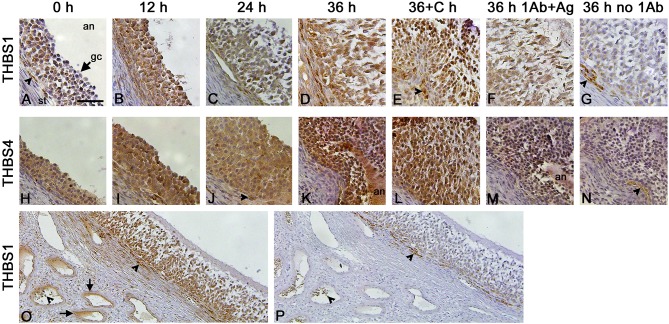
THBS1 and THBS4 immunodetection in monkey ovarian follicles. Immunocytochemical detection (brown) of THBS1 (A–G) and THBS4 (H–N) was localized to the granulosa cell layer of ovulatory follicles obtained before (0; A,H) and 12 (B,I), 24 (C,J), and 36 (D,K) hours (h) after hCG administration as well as 36 h after administration of hCG and celecoxib (36+C h; E,L). Images shown are representative of n-3-6 ovaries/treatment. Granulosa cell immunodetection of THBS1 (F) and THBS4 (M) was reduced after preabsorption of the primary antibody with recombinant human THBS1 or THBS4 and similar to staining observed with no primary antibody (G,N). Nuclei are counterstained blue. All panels are oriented as shown in (A), with stroma (st) in lower left, granulosa cell (gc, arrow) layer central, and follicle antrum (an) in upper right. Arrowheads indicate stromal staining with antibody against THBS1 (A,E), THBS4 (J), and no primary antibody (G,N). Images in (A–N) are at the same magnification; bar in (A) is 50 μm. Lower magnification images shows immunocytochemical detection of THBS1 (O) and no primary antibody (P) stained sections of an ovary obtained after ovarian stimulation and 36 h hCG. Staining is apparent in stromal vessels (O, arrows). Non-specific staining is indicated near the granulosa cell basement membrane and in vessel lumens in (O,P) (arrowheads); bar in (A) is 100 μm for images in (O,P).